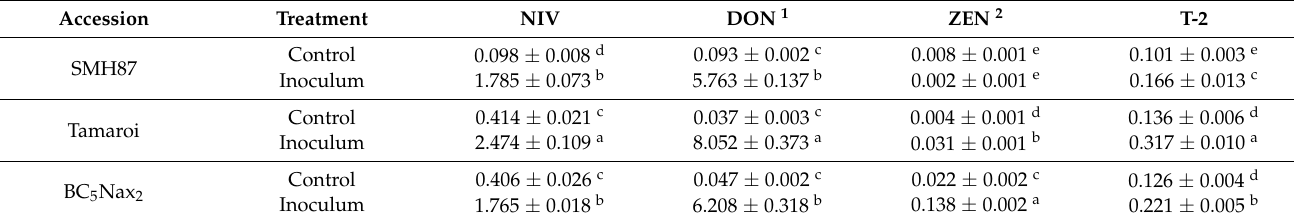
Values represent means ( n = 3) ± SE. Different superscript letters (a–e) within columns indicate significant differences between means (Duncan’s multiple range test; p < 0.05). DON 1 total amount of deoxynivalenol (DON), and 3–acetyldeoxynivalenol (3AcDON)